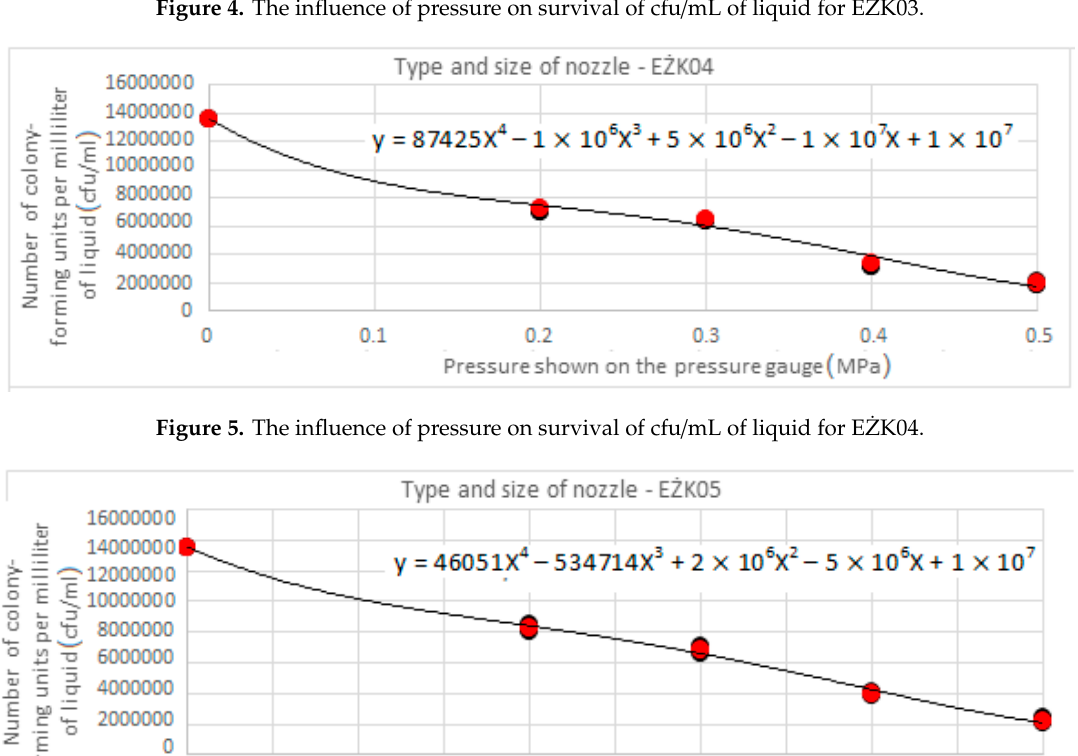
Figure 7. The influence of pressure on survival of cfu/mL of liquid for E Ż K06. Figures 8–13 present detailed characteristics of survival of colony-forming units in the preparation [7] for E Ż KT compact twin jet air induction nozzle at the flow rate of 02–06.